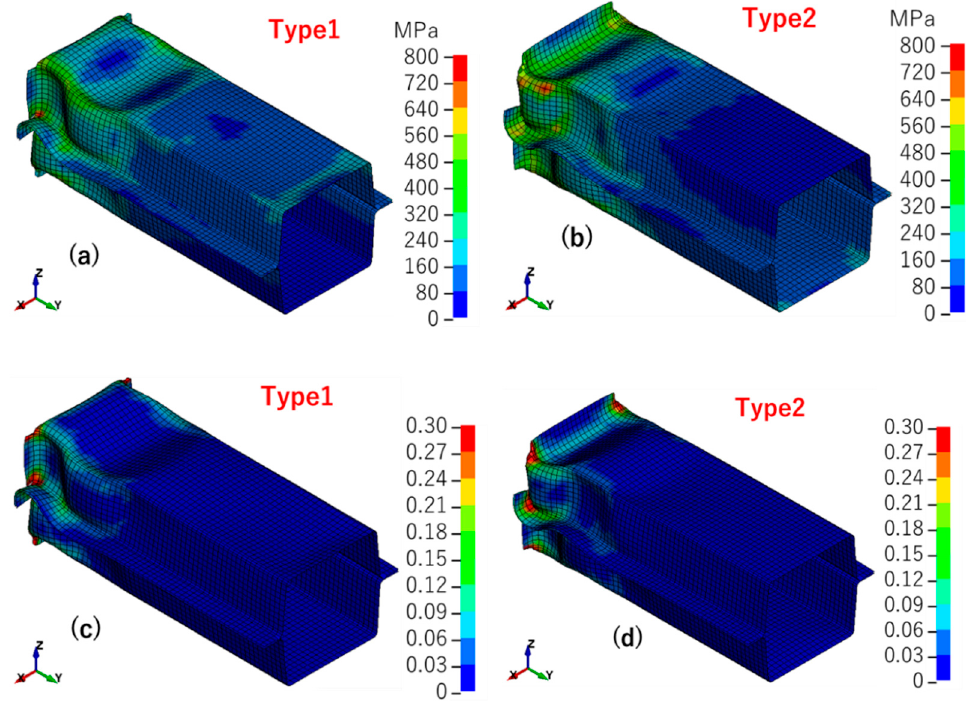
Figure 17. Two types of initial deflection: ( a ) arched type; ( b ) wavy type.